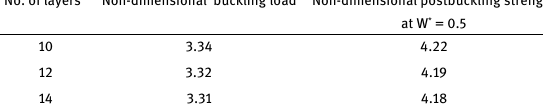
Table 6: Convergence study for buckling load and postbuckling strength (corresponding to W * = 0.5) for SSSS FG-A CNT-reinforced nanocomposite square plate under uni-axial compression, for b / h = 50.